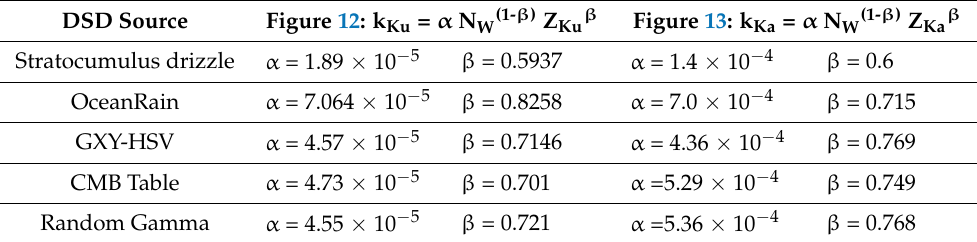
Table 3. Fitted coefficient α and the exponent β , corresponding to Figures 12 and 13. DSD Source Figure 12: k Ku = α N W(1- β ) Z Ku β Figure 13: k Ka = α N W(1- β ) Z Ka